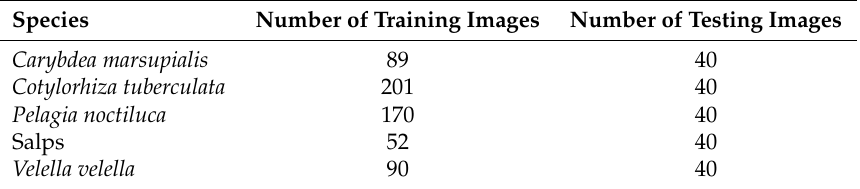
Figure 2. Original ( left ) and cropped ( right ) versions of a Pelagia noctiluca training image. Table 1. Number of training and testing images per